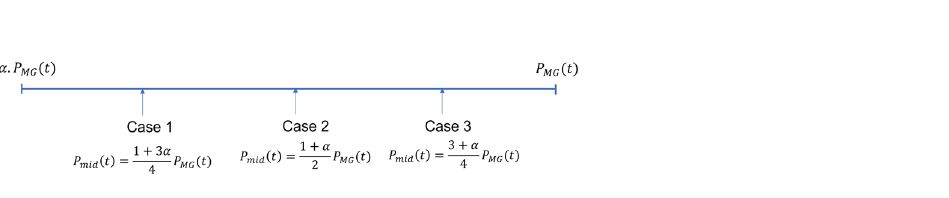
Figure 11. Values of P mid ( t ) considered in three